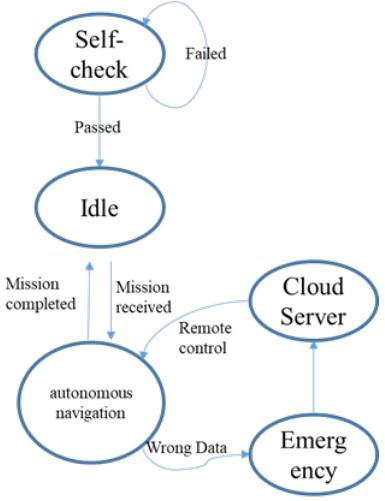
Figure 2. State machine logic structure.